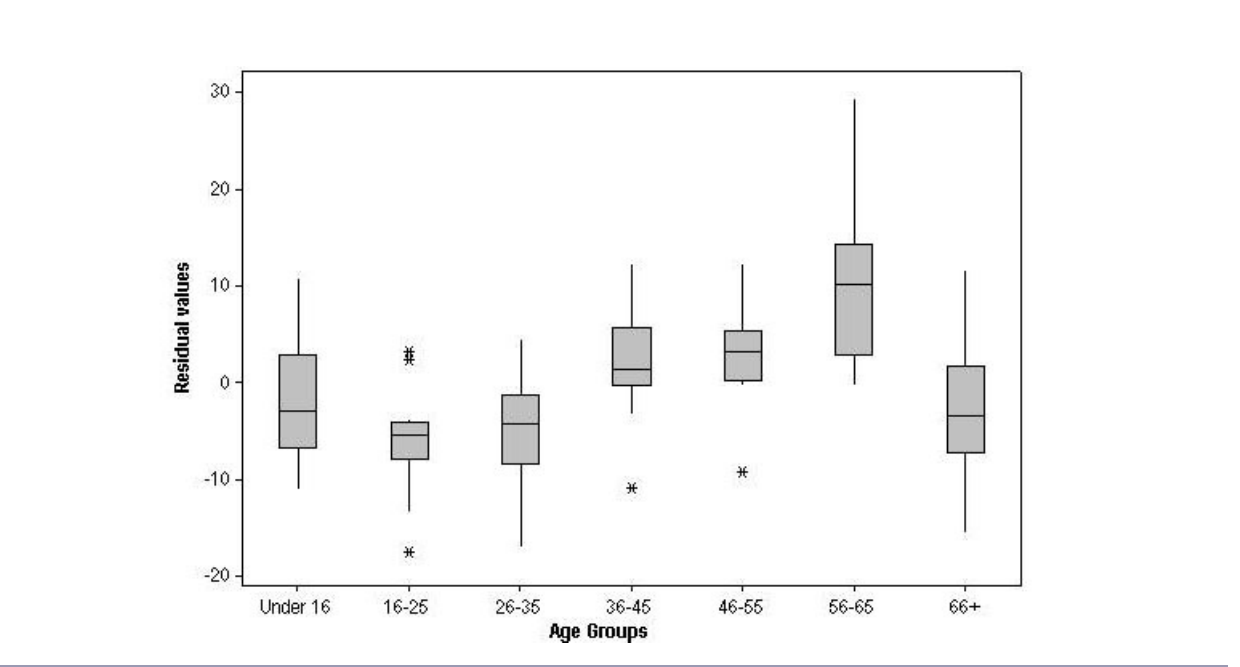
Fig. 5 . Residuals of age groups for the